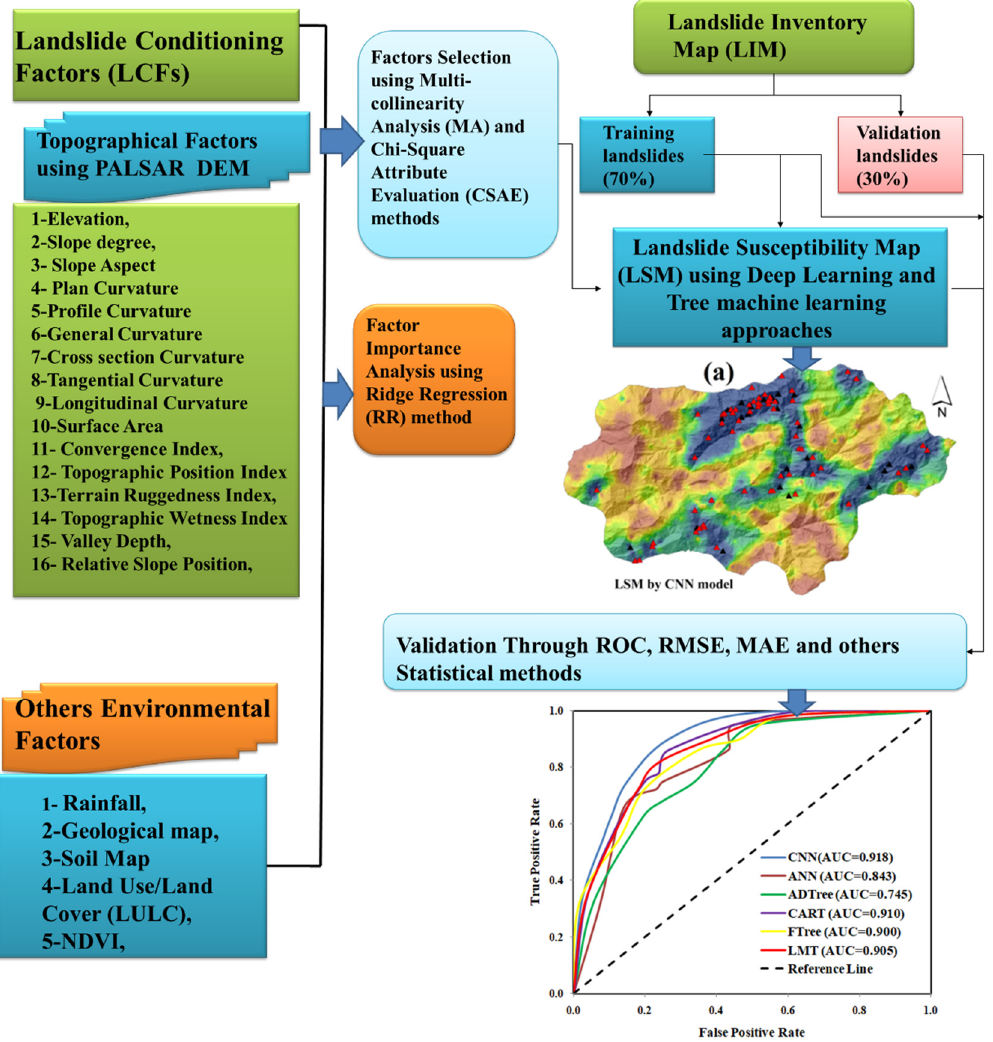
Figure 2. Flowchart representing the methodology.